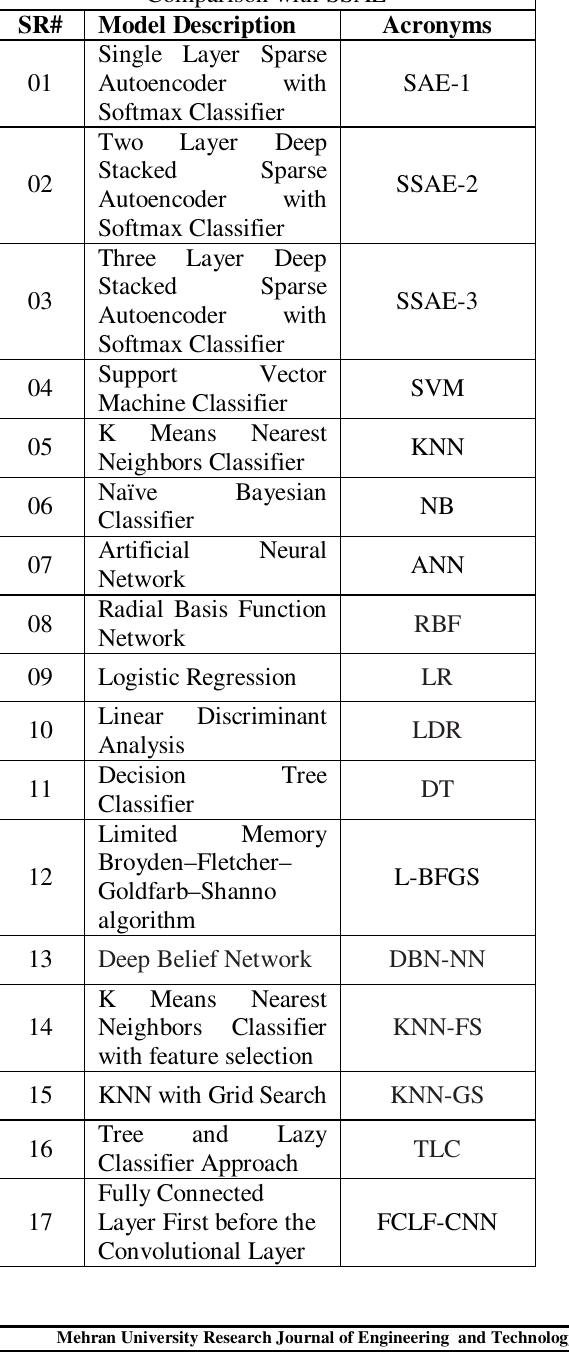
Table 1: Comparative Models for Accuracy